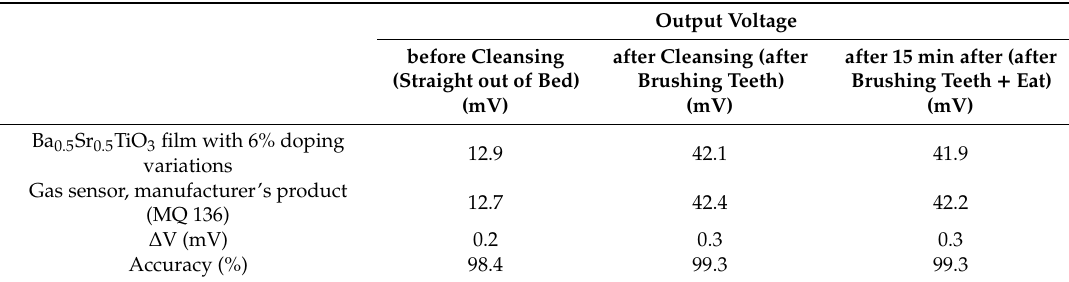
Table 3. Measurement data of the accuracy of the voltage value between Ba 0.5 Sr 0.5 TiO 3 film RuO 2 6% doped relative to the commercially manufactured gas sensor (MQ 136) when detecting the odor conditions of the oral